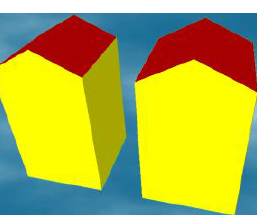
Figure 12. Healing CS_CONCOMP error